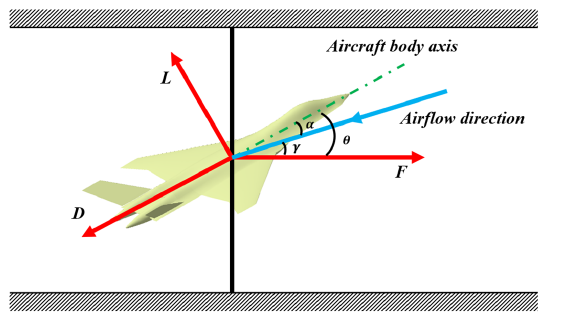
Figure 16. Force analysis of the aircraft installed in the present support system.